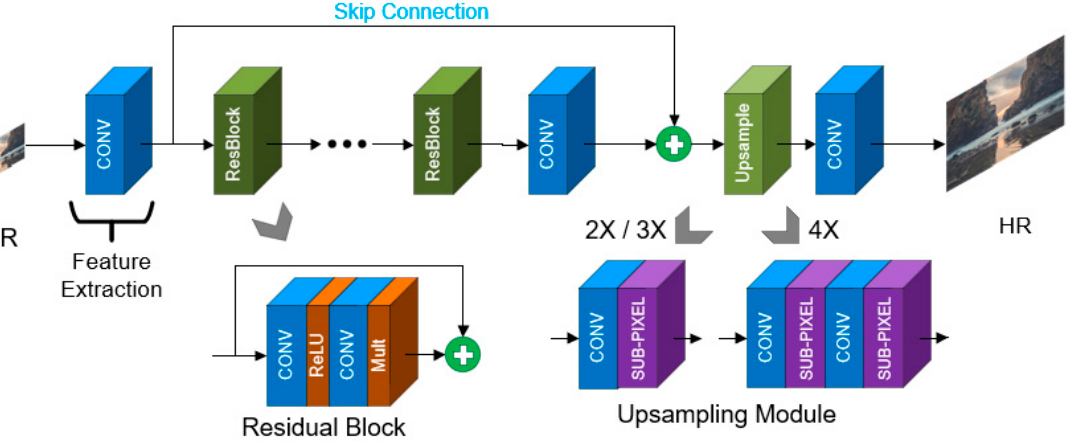
Figure 6. EDSR network structure.